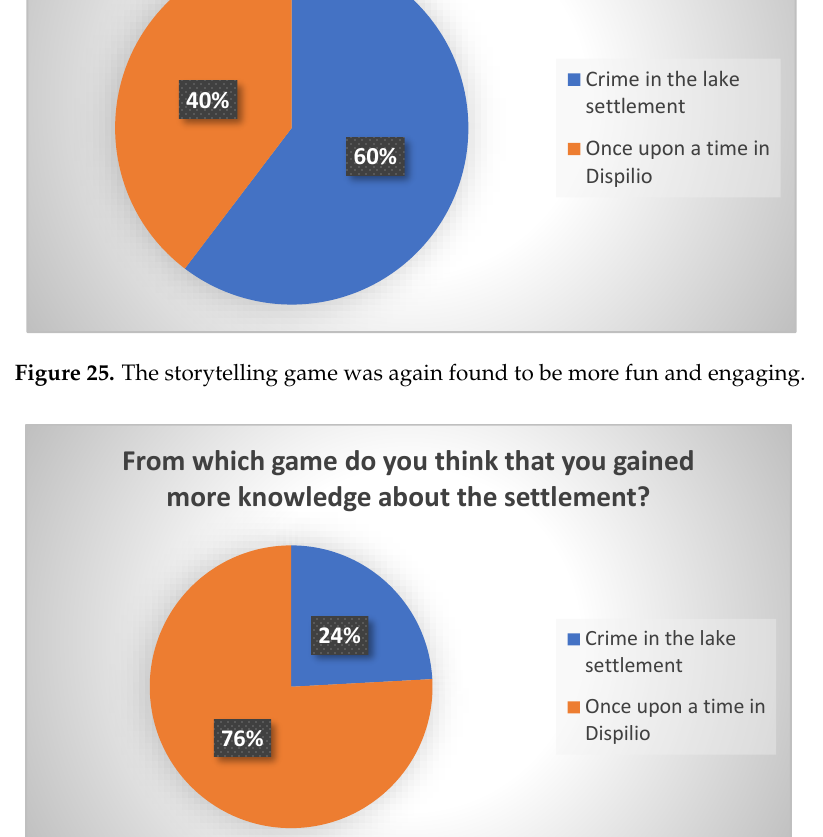
Figure 26. Students again thought that they learned more from the informative game.